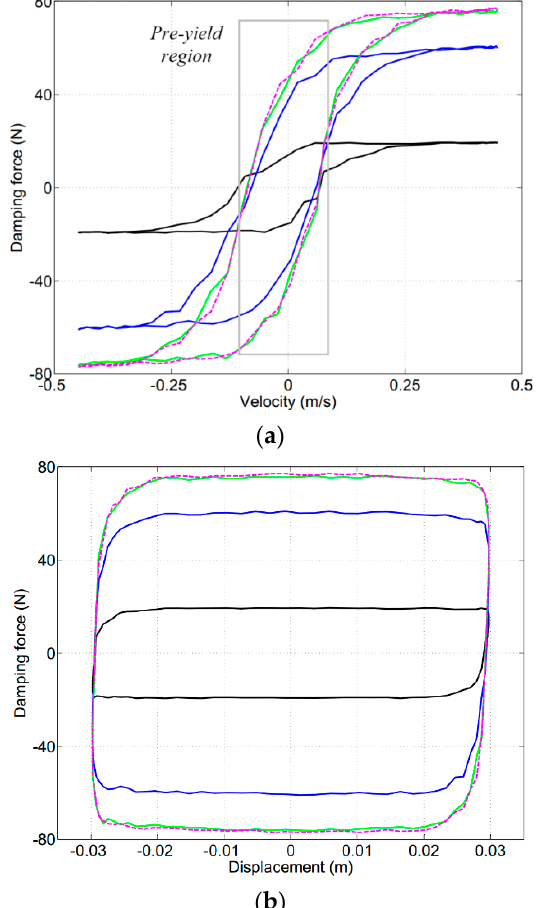
Figure 15. Experimental responses under a frequency of 2.4 Hz, an amplitude of 30 mm, and different currents of 0, 0.2, 0.34 (continuous lines from inside to outside), and 0.4 A (dash line): ( a ) force vs. velocity and ( b ) force vs. displacement.